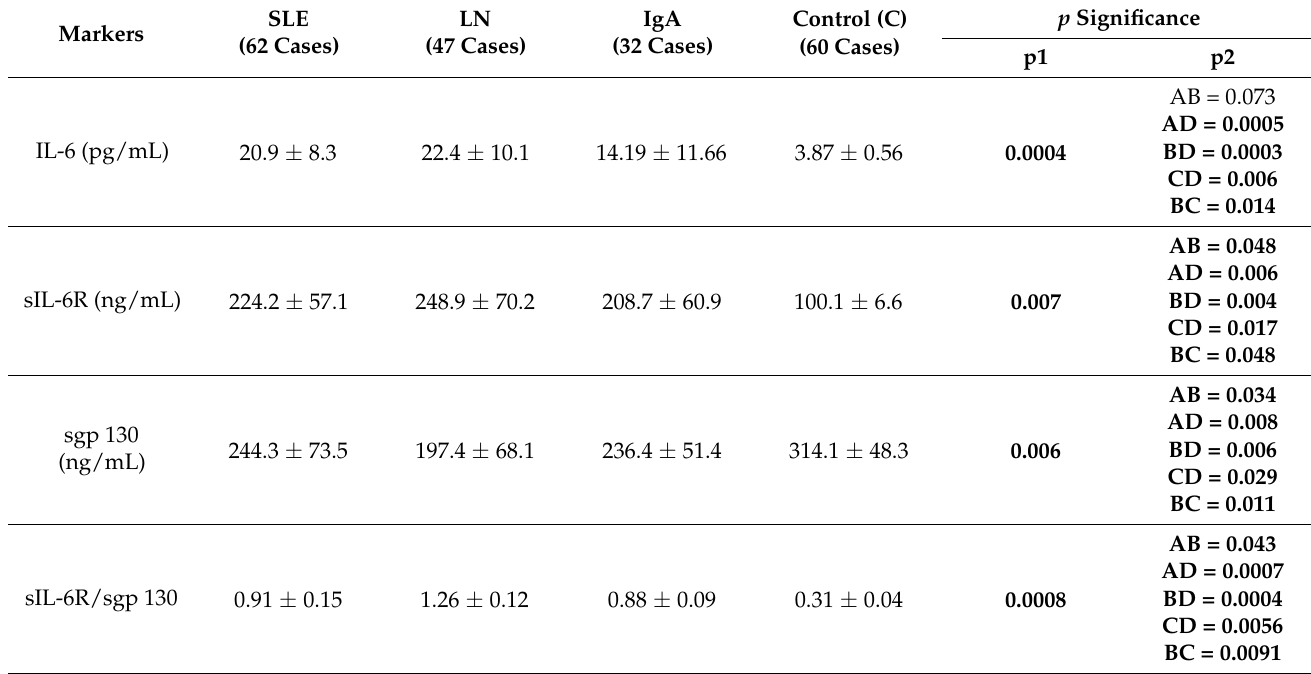
Table 4. IL-6 signaling in the studied